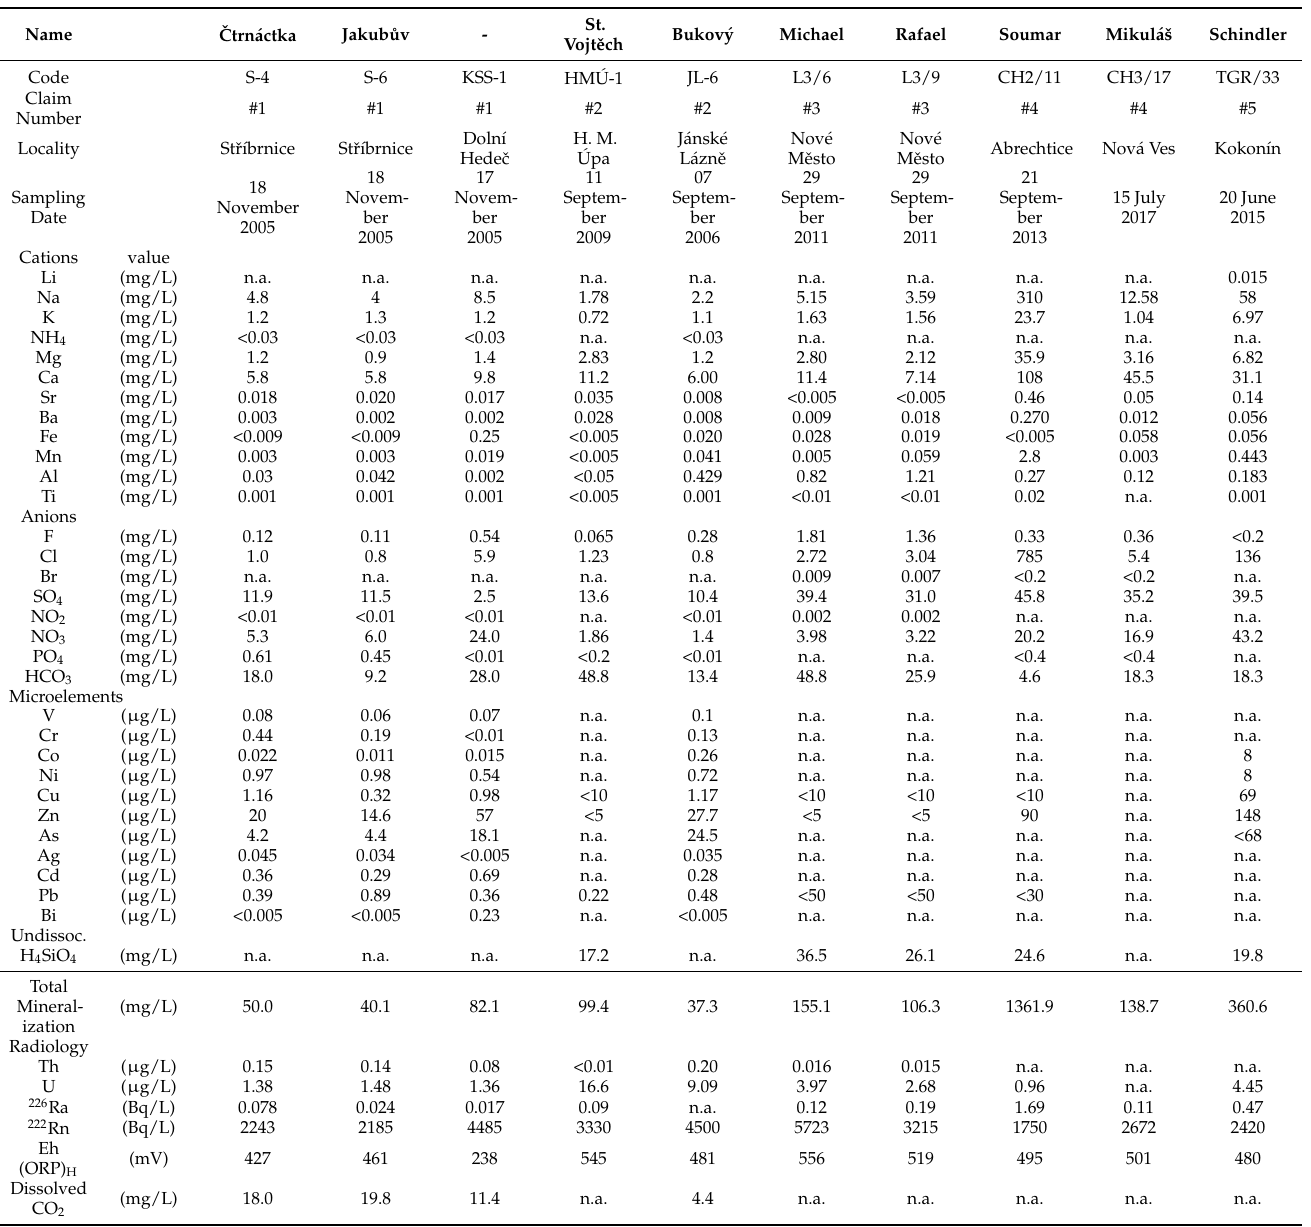
Table A1. Chemical composition of the ten most important sources of radioactive mineral waters from the Lugian